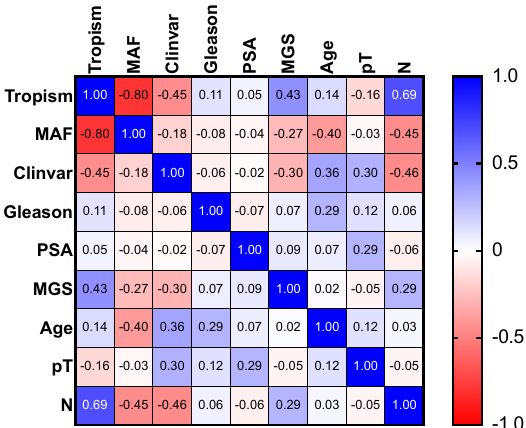
Figure 1. Correlation matrix (above) and p -values (under) reported for the correlation analysis. In the correlation matrix, the red color represents a complete negative correlation, while the blue color represents a complete positive correlation. The 0 value represent absence of correlation between the two variables. MAF = minor allele frequencies; Clinvar = clinical stage; MGS = multiparameter genetic score; pT = pathological stage; N = pathological lymph node metasta- sis; MAF = minor allele